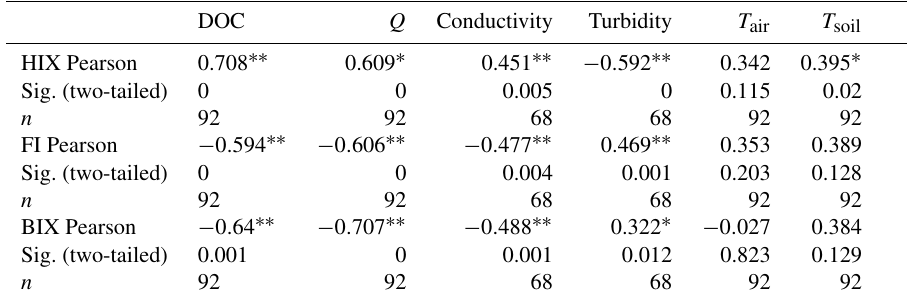
Table 4. Correlation analysis of the three fluorescence indices with hydrological and climatic factors. DOC